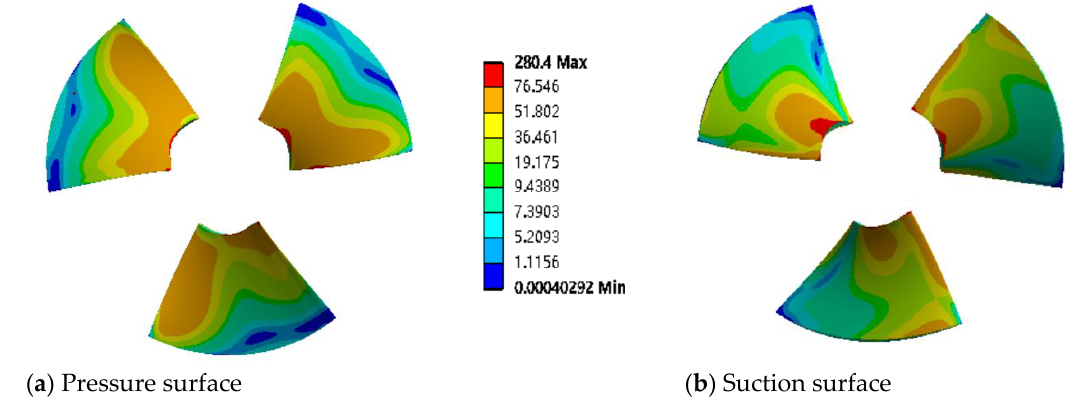
Figure 16. Q = 28 m 3 /s Equivalent force distribution of impeller, Unit: MPa.